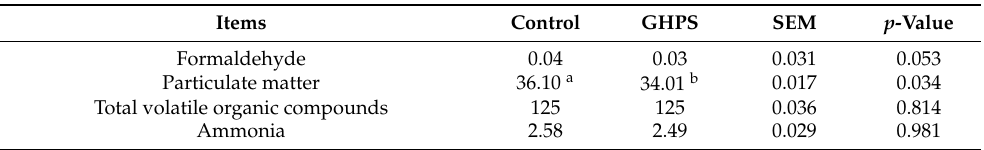
Table 4. Effect of the combined geothermal and solar heating system (GHPS) on formaldehyde (ppm), particulate matter ( µ g/m 3 ), total volatile organic compounds ( µ g/m 3 ), and ammonia concentration (ppm).